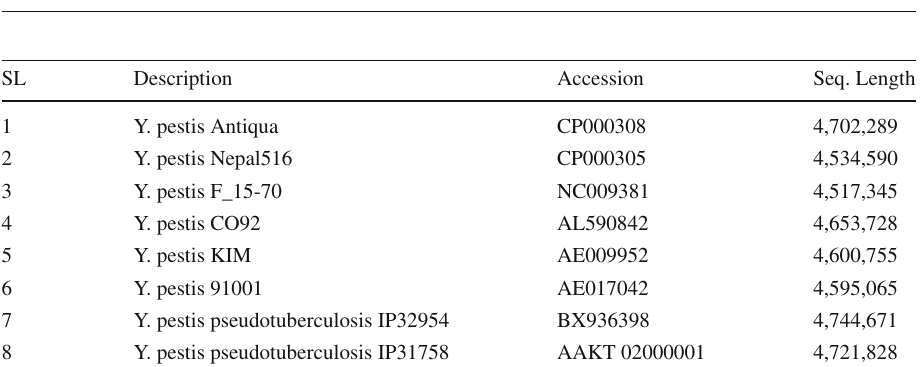
Table 2 Description of 8 Yersinia